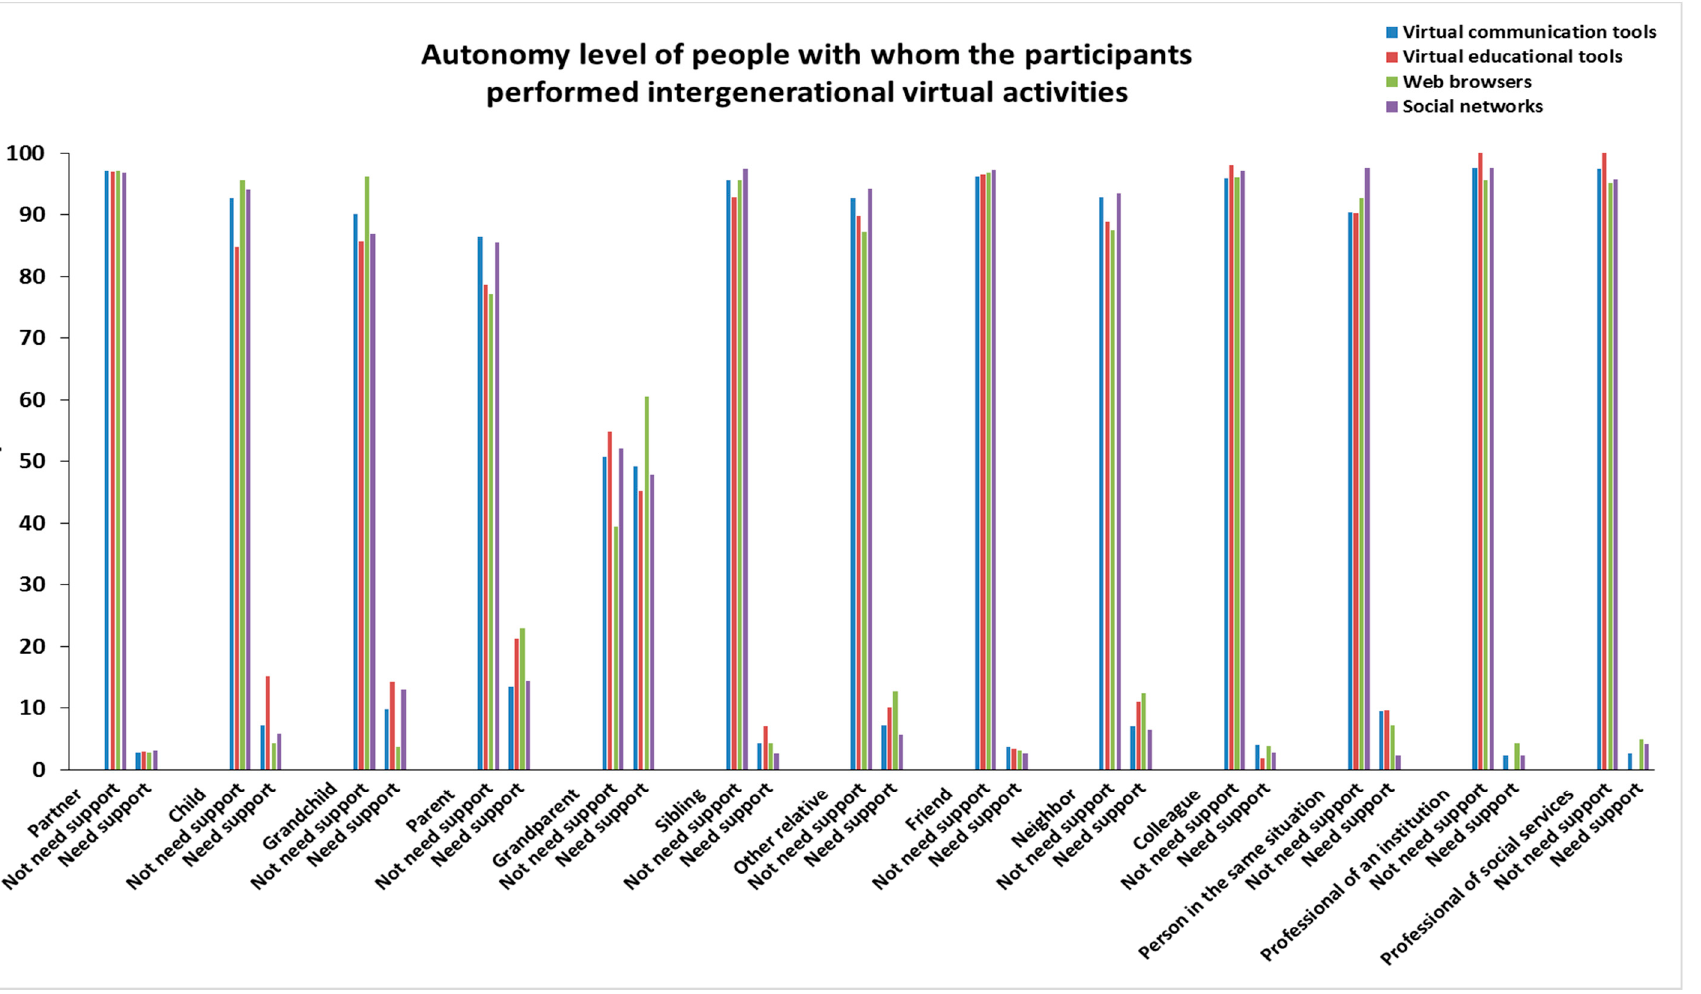
Figure 3. Autonomy level of people with whom the participants performed intergenerational virtual activities.